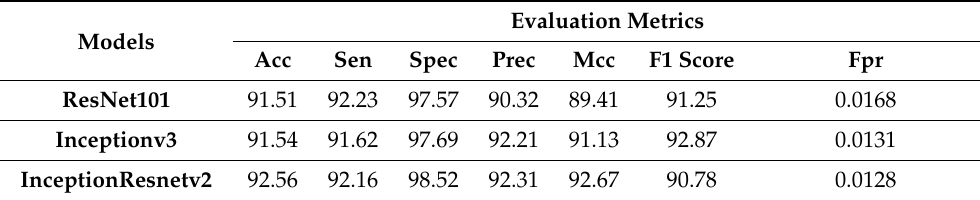
Table 10. Results for pre-trained MCSVM-based models with image SR using dataset